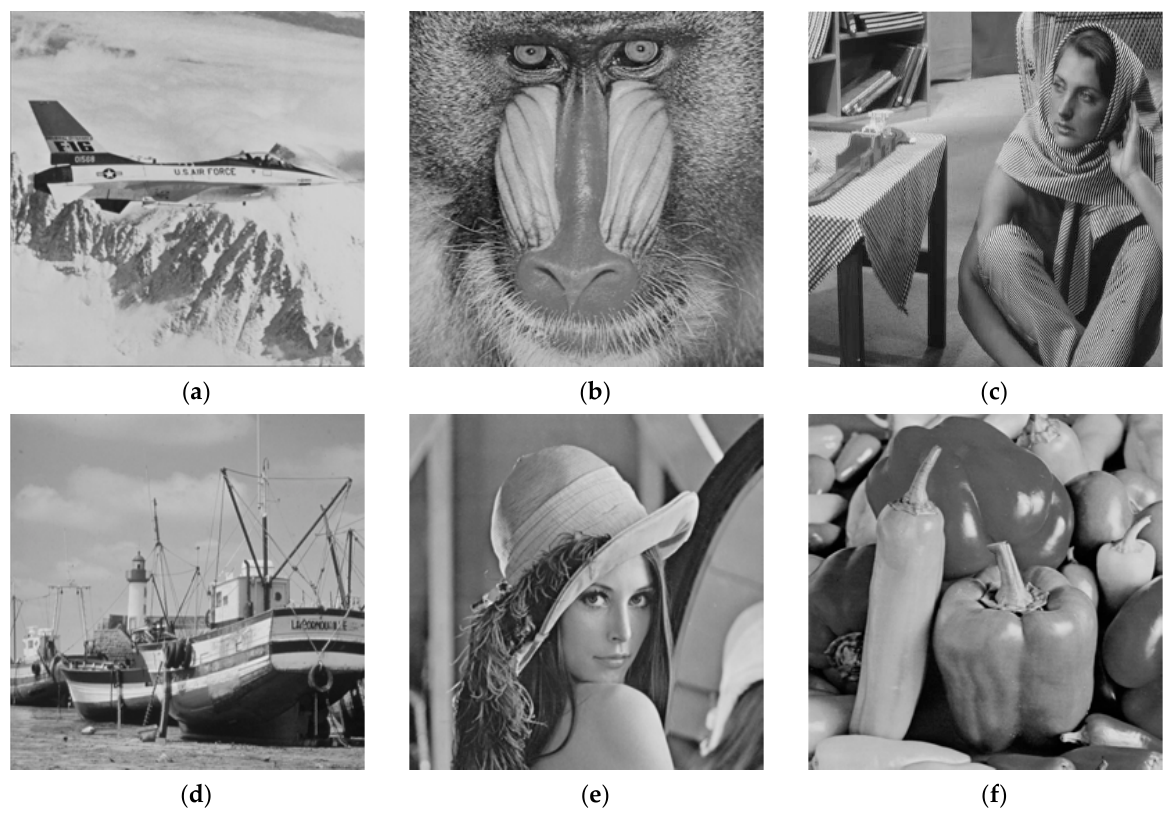
Figure 4. Grayscale test images: ( a ) Airplane; ( b ) Baboon; ( c ) Barbara; ( d ) Boat; ( e ) Lena; ( f ) Pepper. PSNR is typically used to assess the quality between original and modified images after embedding (stego image). PSNR calculation is denoted in Equation (3), and the mean square error (MSE) is denoted in Equation (4):